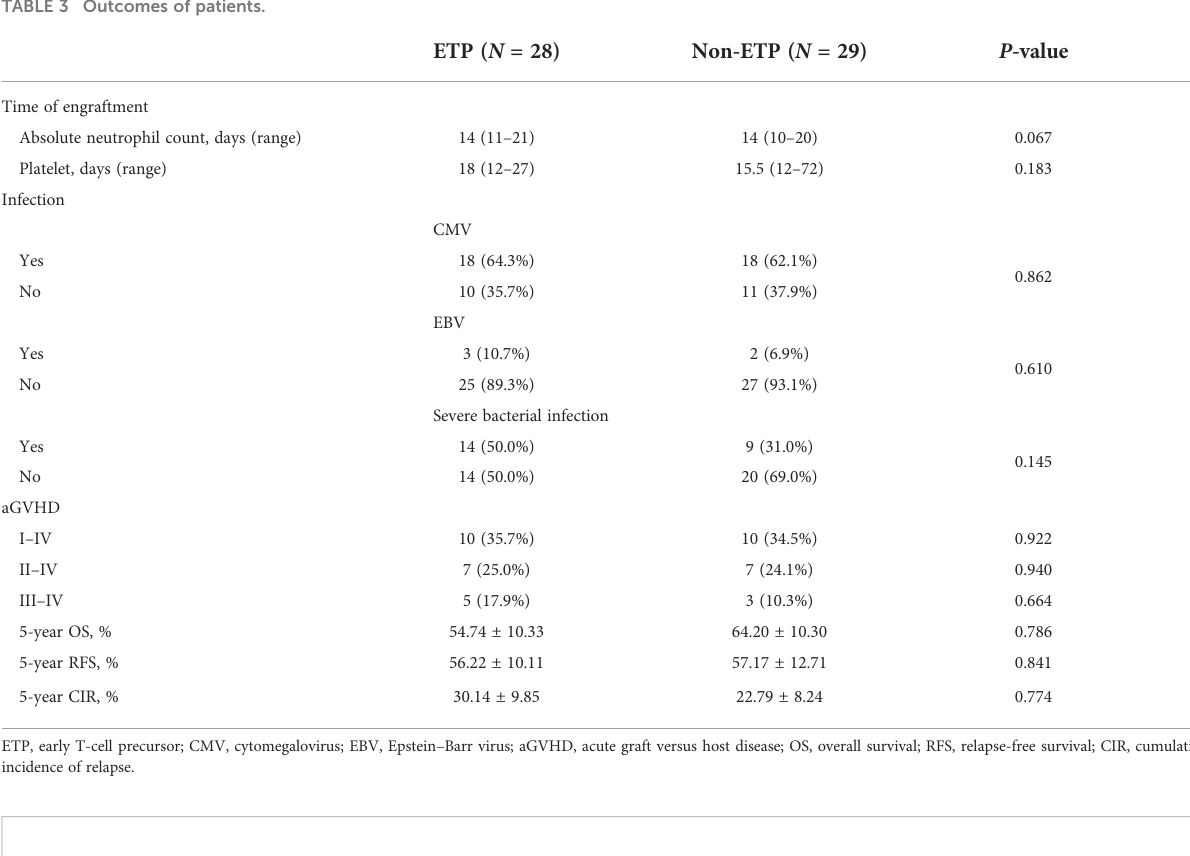
TABLE 3 Outcomes of